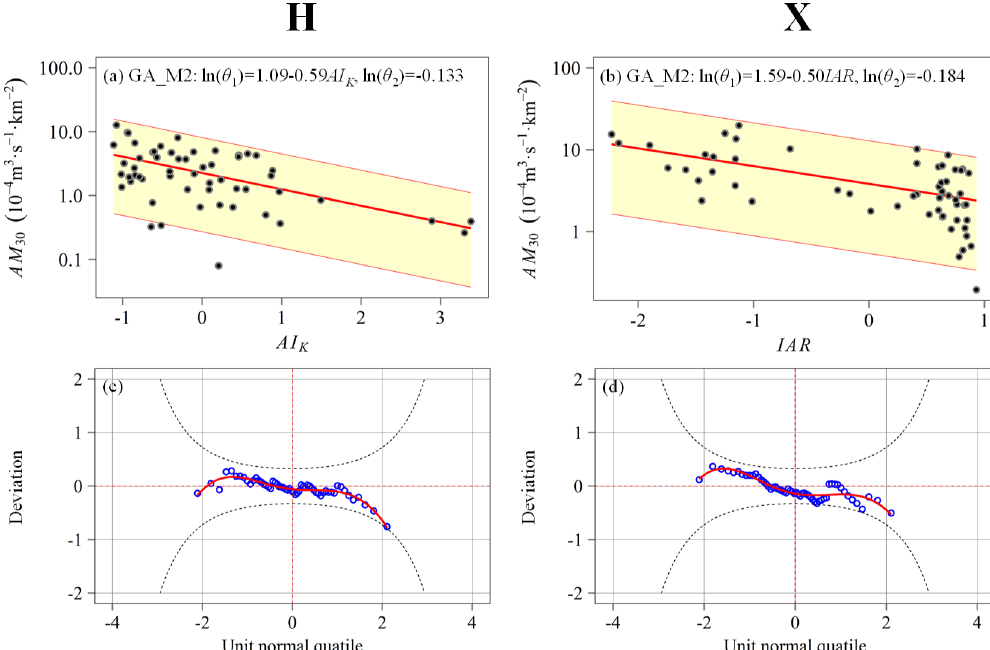
Figure 8. Performance assessments of GA_M2 for AM 30 in Huaxian (H) on the left panel and Xianyang (X) on the right panel. (a) and (b) are the centile curves plots of GA_M2 (red lines represent the centile curves estimated by GA_M2; the 50th centile curves are indicated by thick red; the yellow-filled areas are between the 5th and 95th centile curves; the black points indicate the observed series); (c) and (d) are the worm plots of GA_M2 for the goodness-of-fit test; a reasonable model fit should have the data points fall within the 95% confidence intervals (between the two red dashed curves).